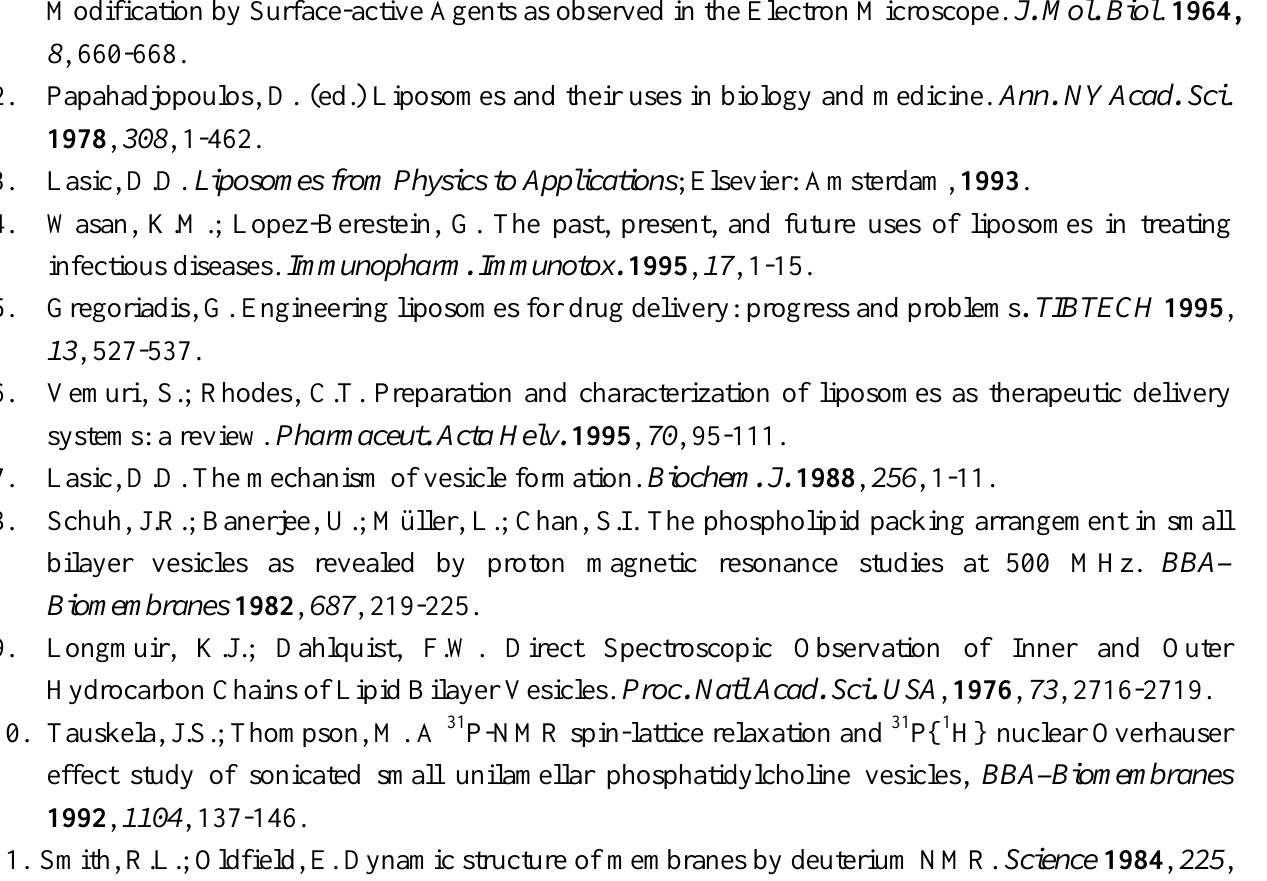
Table 1. No temperature difference was registered for the samples of LUVs and MLVs during the MAS experiments at the same spinning speed, as reported in column 3 of Table